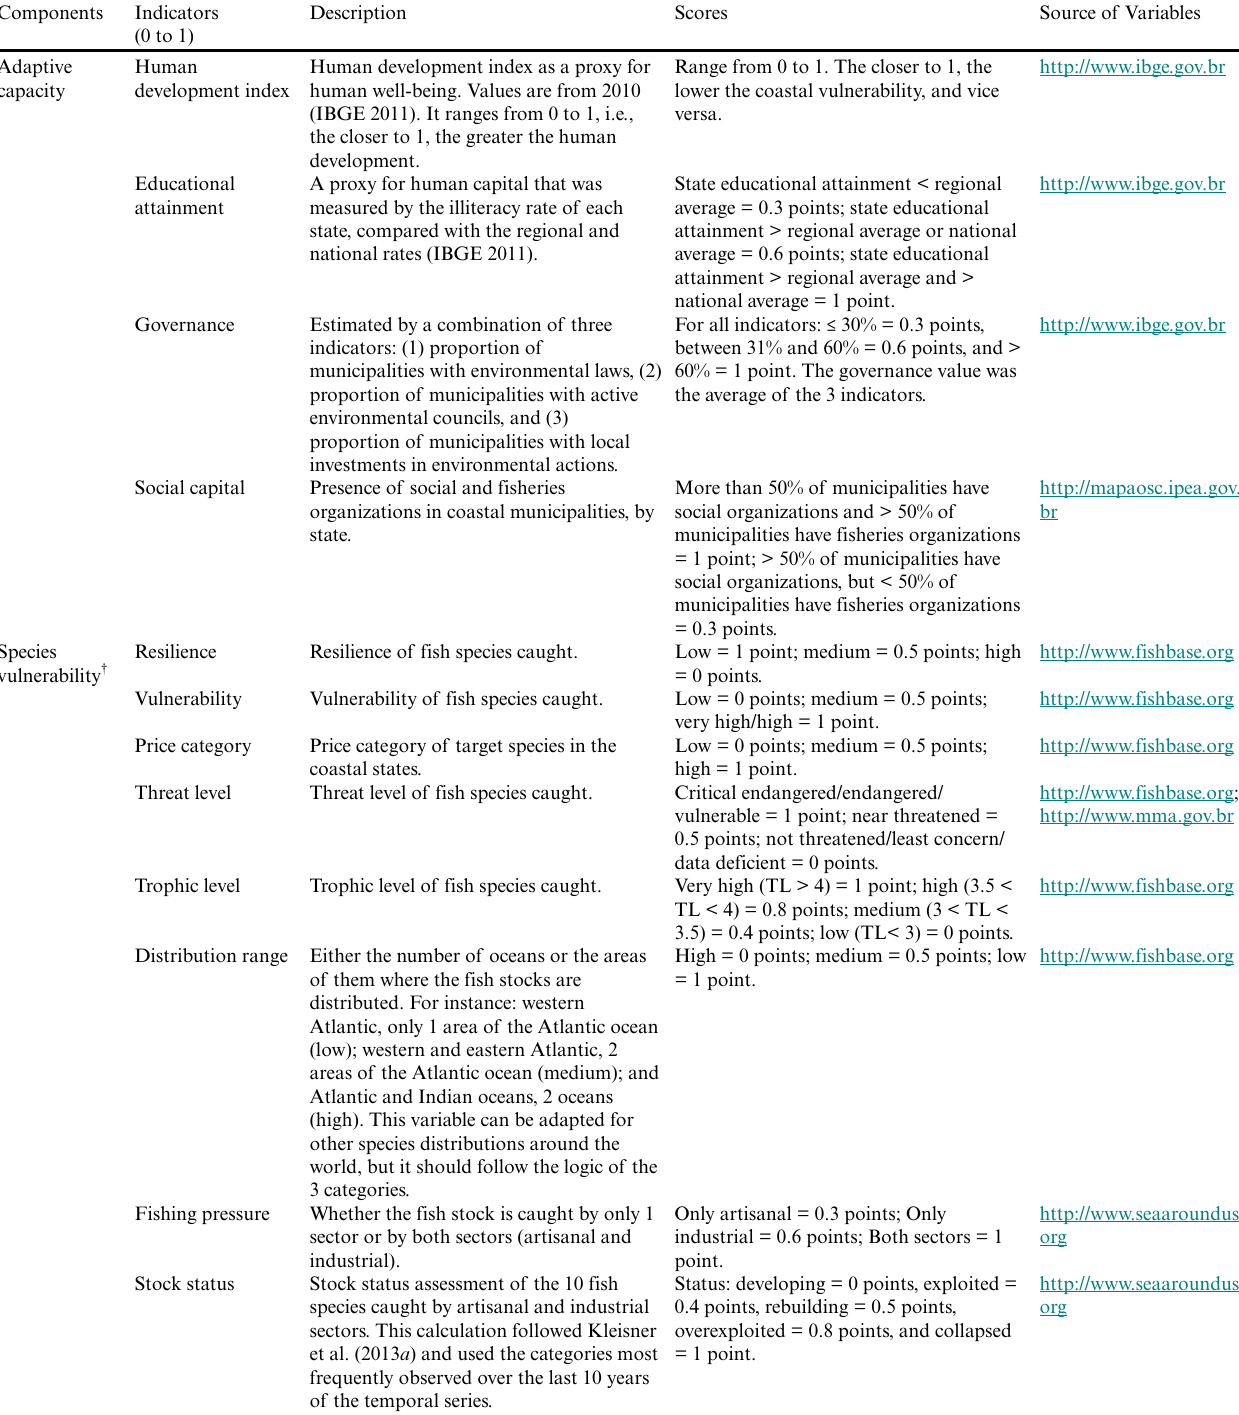
Table 2 . Design of the Index of Coastal Vulnerability (ICV). Components and their indicators, description of each variable, score calculation, and source of variables are detailed. ICV is the sum of species vulnerability and ecosystem vulnerability components minus the adaptive capacity of the coastal states. IBGE, Brazilian Institute of Geography and